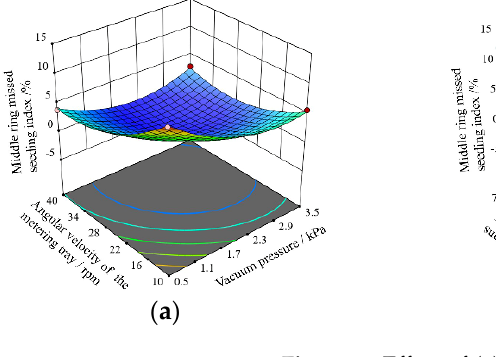
Figure 8. Effect of ( a ) angular velocity of metering tray and vacuum pressure, ( b ) taper angle of sucking hole and vacuum pressure, and ( c ) taper angle of sucking hole and angular velocity of metering tray on the middle ring missed seeding index.